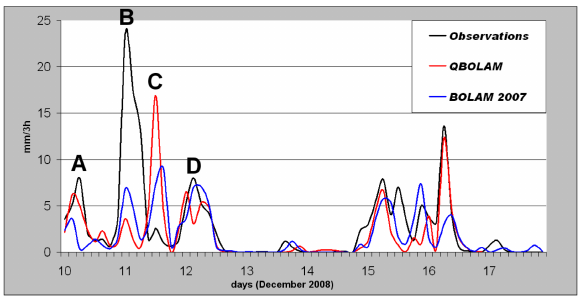
Fig. 5. Time series comparison during the December 2008 event between the observed precipitation values averaged over the low Tiber valley and the corresponding average values predicted by the two BOLAM’s versions.